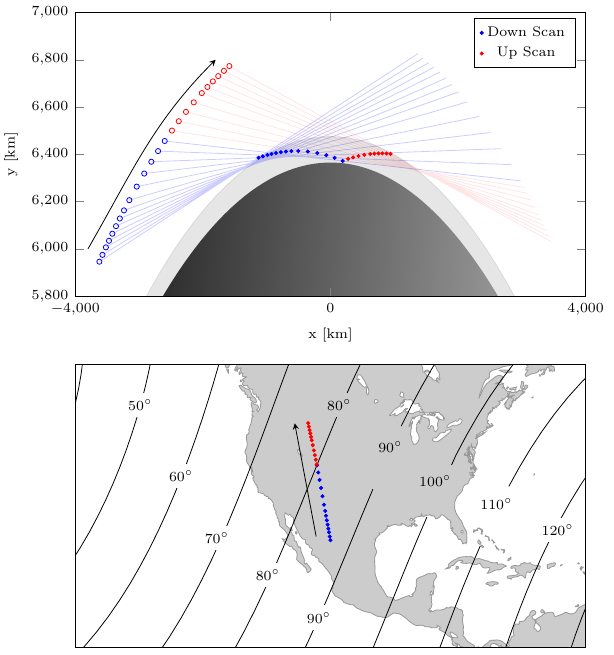
Figure 6. Typical movement of the Odin satellite (open circles) and tangent point (closed circles) as the line of sight is scanned down and up, shown in red and blue respectively. The bottom panel shows the ground tracks of the tangent points; contours mark lines of con- stant zenith angle.